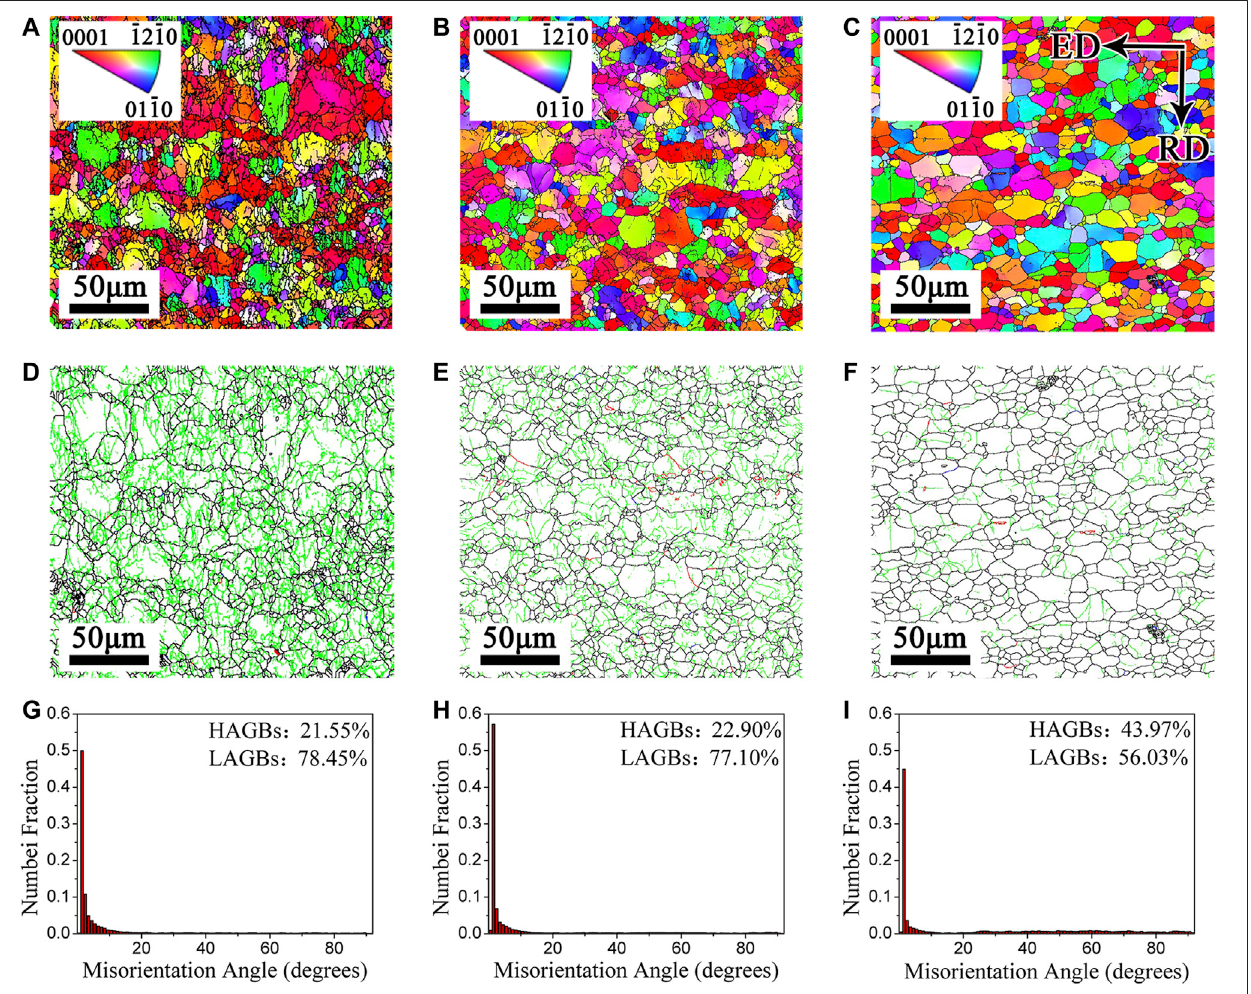
FIGURE 7 | IPF maps, grain boundary maps, and misorientation angle distribution histograms of the LAY410 alloy at the same rate with different temperatures: (A,D,G) T (cid:2) 150 ° C, (B,E,H) T (cid:2) 200 ° C, (C,F, and I) T (cid:2) 250 ° C.